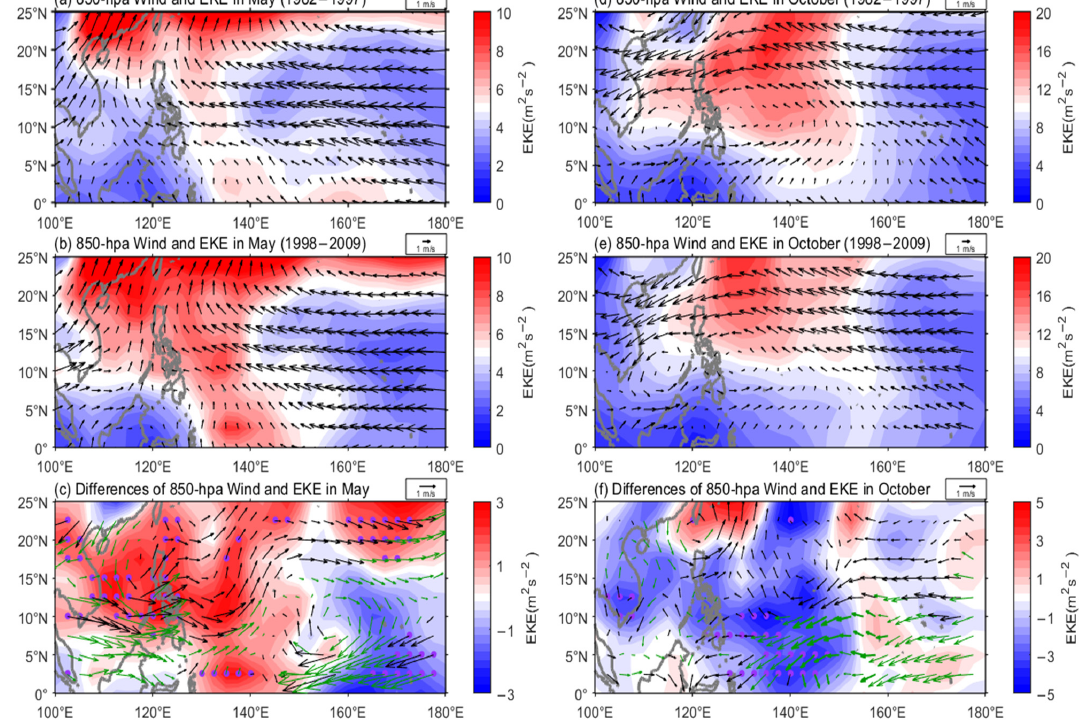
Figure 5. Comparisons of 850-hPa winds (vectors) and eddy kinetic energy (EKE) (shading) between two sub-periods in May ( a – c ) and October ( d – f ). Mean 850-hPa winds (vectors) and EKE (shading) in May during ( a ) P1 (1982–1997) and ( b ) P2 (1998–2009). ( c ) Differences of 850-hPa winds (vectors) and EKE (shading) between P2 and P1 in May. As in ( a – c ), but for October ( d – f ). Signals above the 90% confidence level are highlighted by green vectors (for winds) and purple dots (for